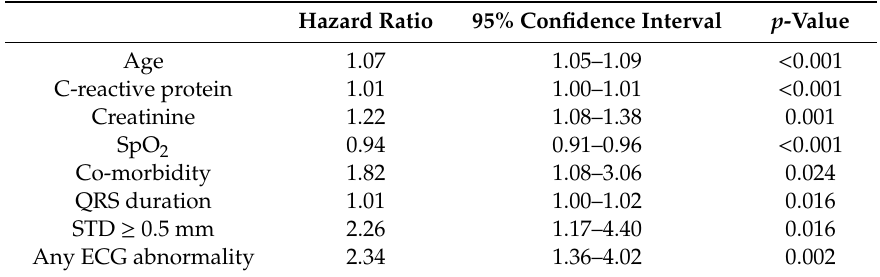
Table 4. Main results of multivariable survival Cox regression analysis in the whole population.